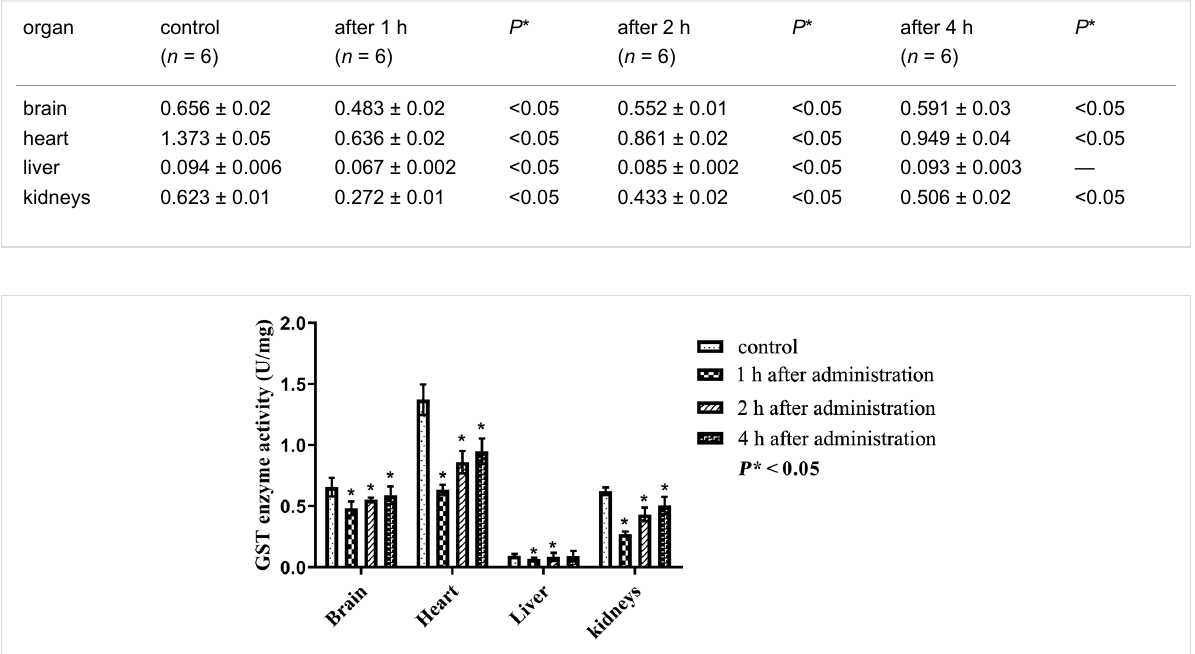
Figure 10: Activity of glutathione S-transferase enzyme activity after intraperitoneal administration of PEG-nGO, error bars: one standard